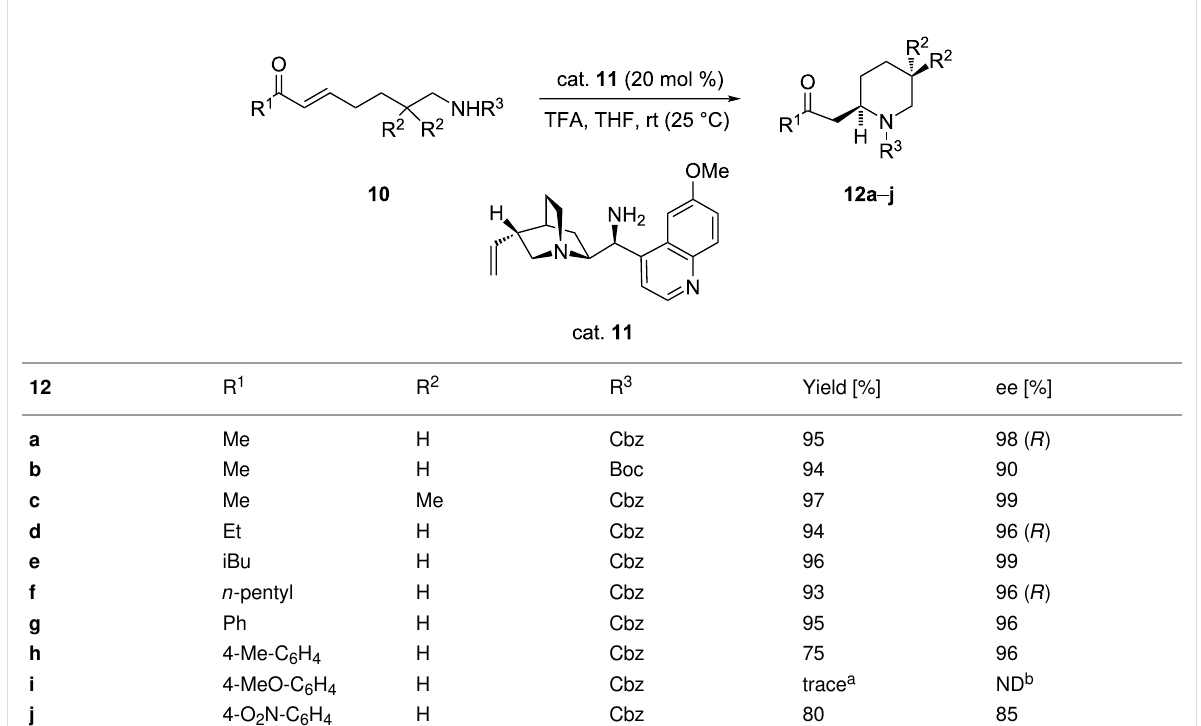
Table 2: Intramolecular aza-Michael addition of conjugated ketones.